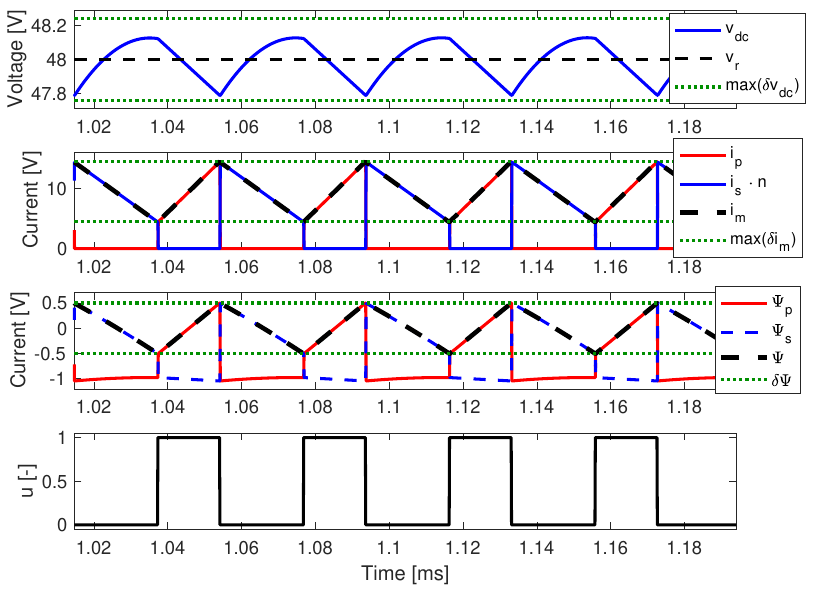
Figure 11. Steady-state operation for i dc = 1